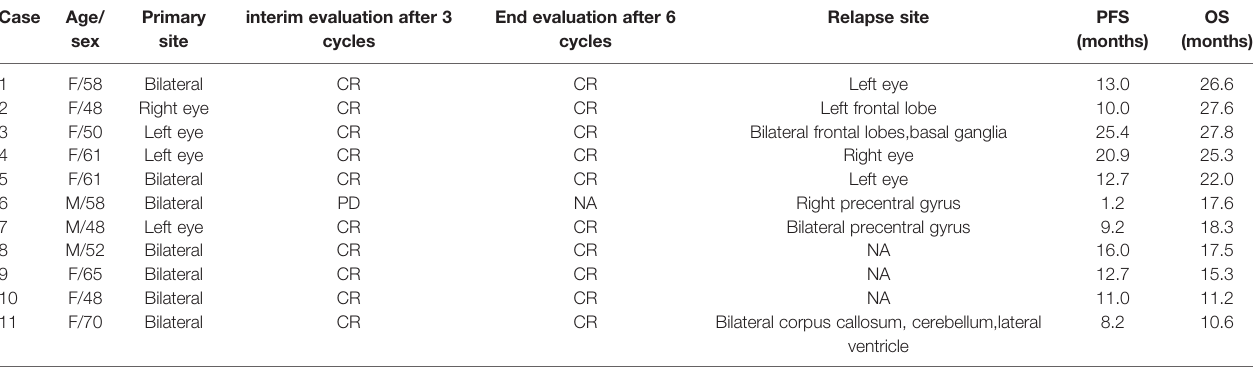
TABLE 2 | Patient characteristics, clinical fi ndings, response and disease free survival.